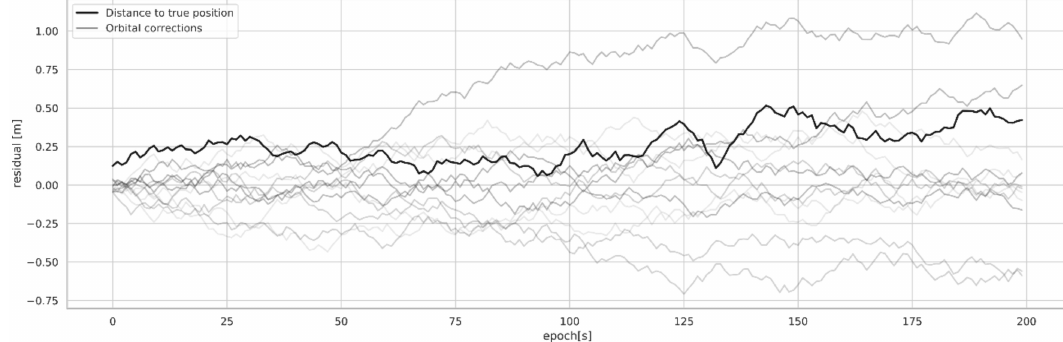
Figure 17. Influence of degrading orbital corrections on PPP